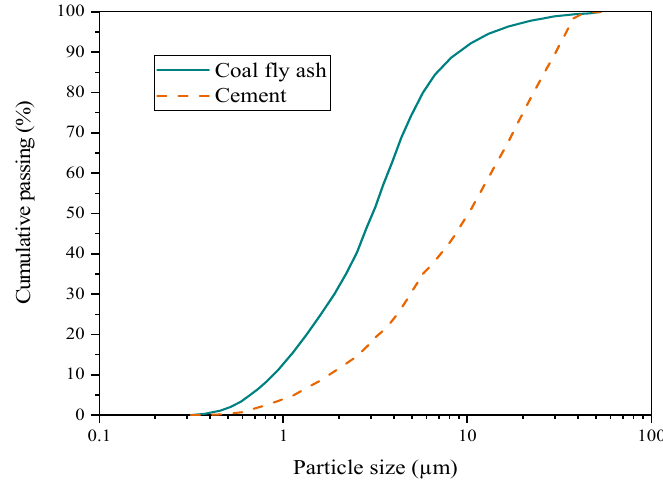
Figure 2. PSD of coal fly ash and cement.